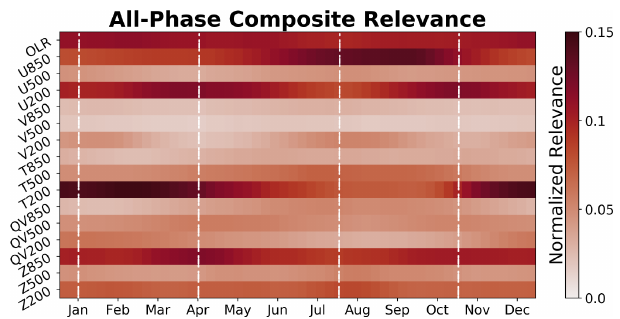
Figure 8. Composite normalized LRP relevance across all variables for each calendar week throughout the year. The relevance is nor- malized to sum to 1 across all variables for each calendar week (i.e., along the vertical